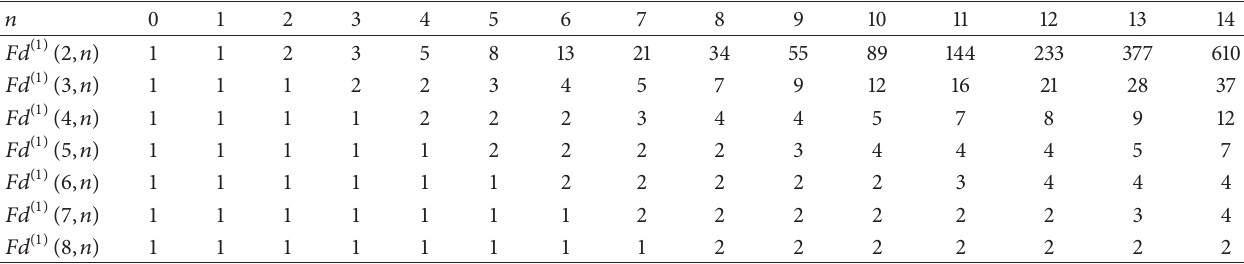
Table 1: The 𝑛 th distance Fibonacci numbers 𝐹𝑑 (1) (𝑘,𝑛) .